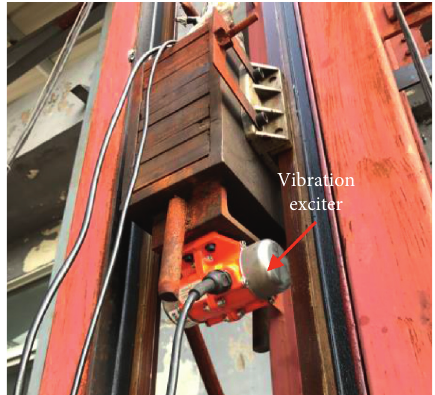
Figure 5: Schematic diagram of the